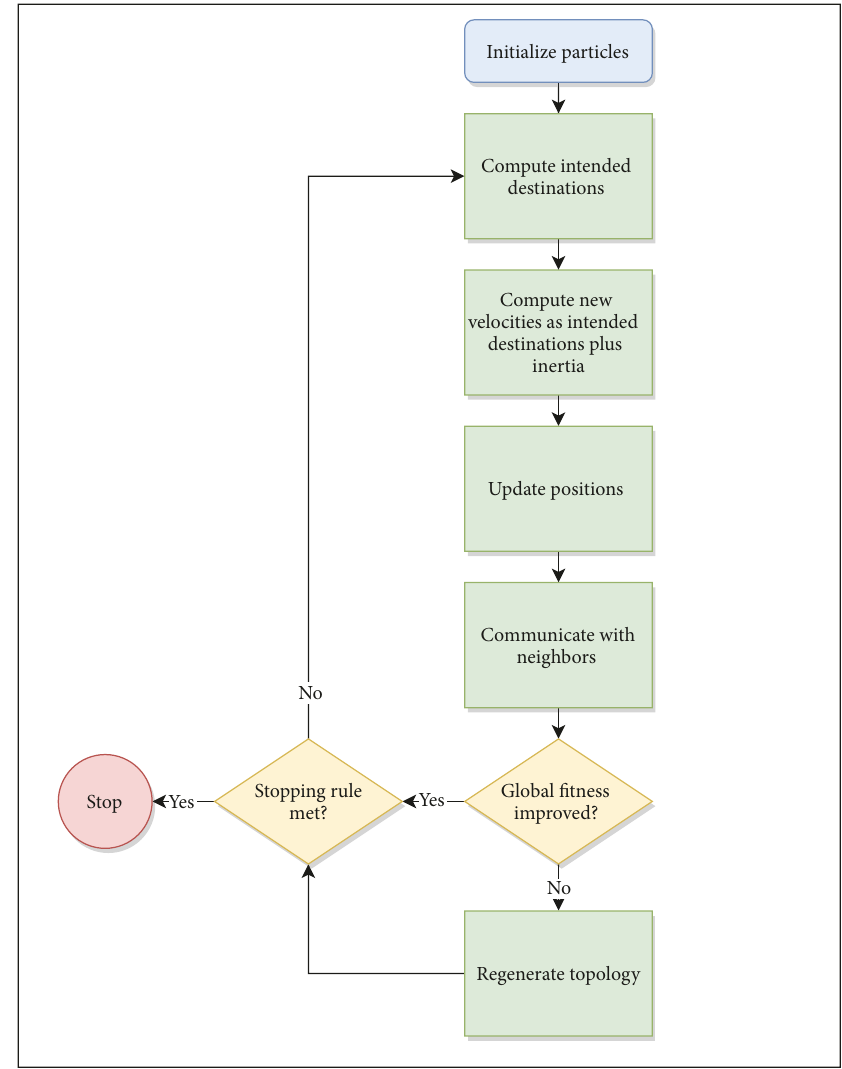
Figure 1: Particle Swarm Optimization